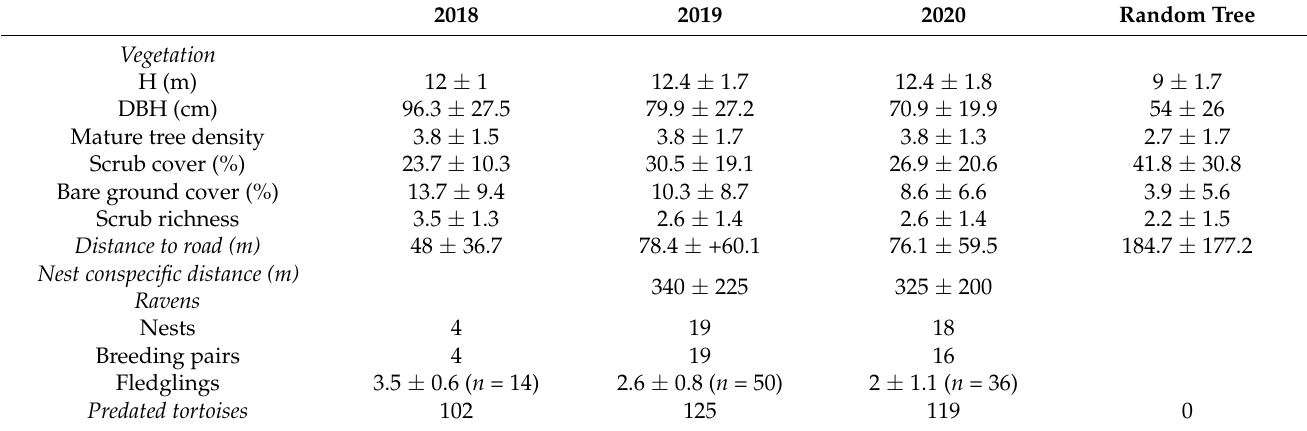
Table 1. Characteristics of trees with and without (random tree) Common raven Corvus corax nests: height (H) and diameter at breast height (DBH), density of mature trees (>30 cm DBH within a radius of 15 m), scrub and bare ground cover in 200 m radius, nearest road distance and nearest conspecific nest distance in the study area for the three seasons included in this study. Finally, descriptive results concerning raven and tortoise sampling are also provided. When possible, standard deviations for each parameter are